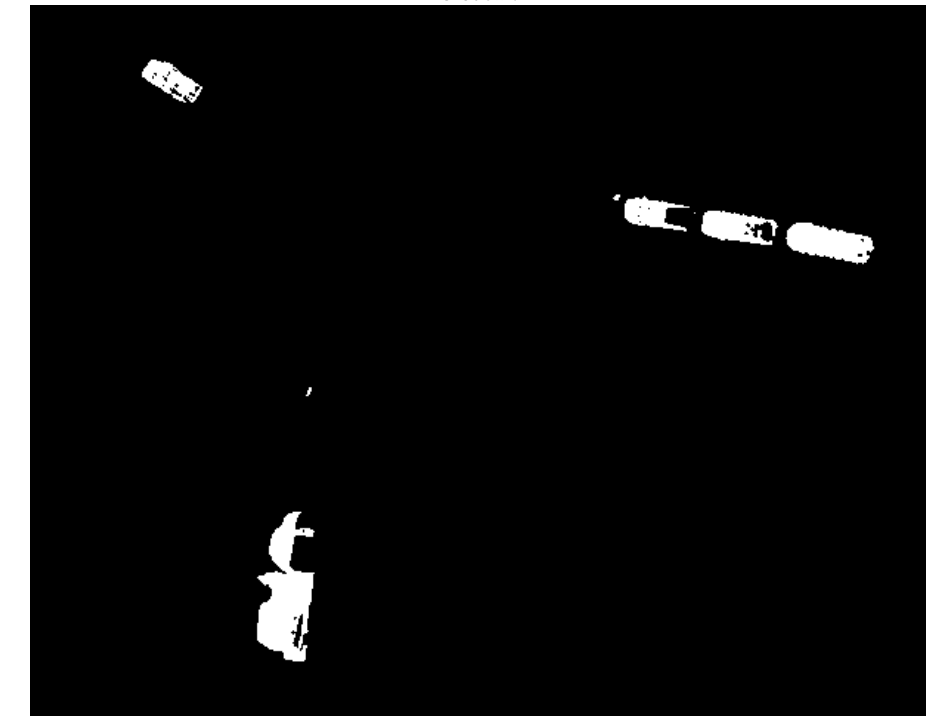
Figure 6a. This is the result after applying filtering on the image. The algorithm couldn’t distinguish between the vehicle and its shadow.